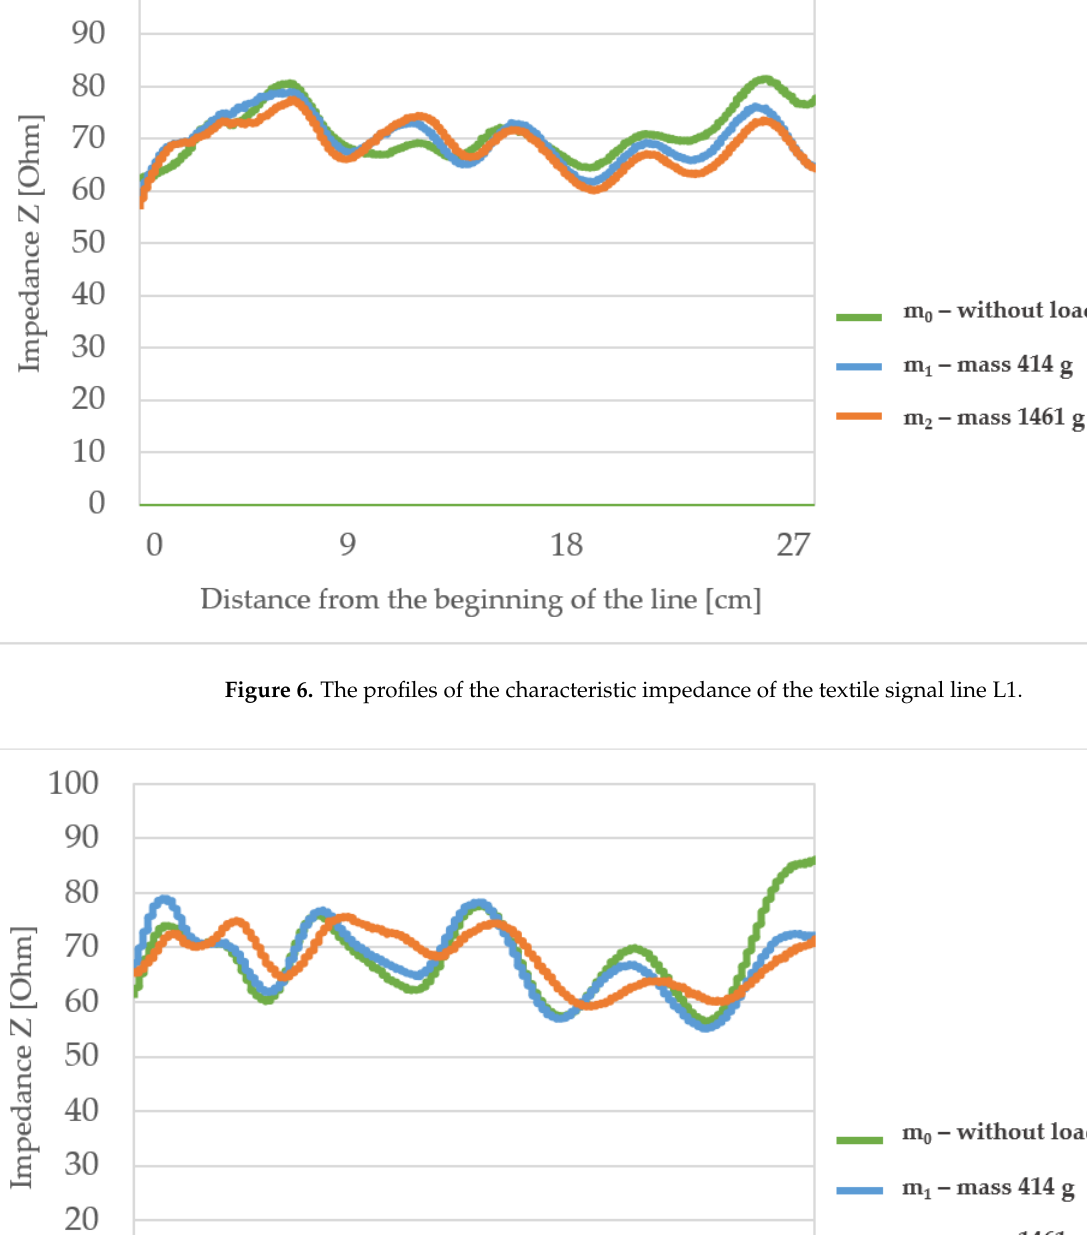
Figure 6. The profiles of the characteristic impedance of the textile signal line L1.